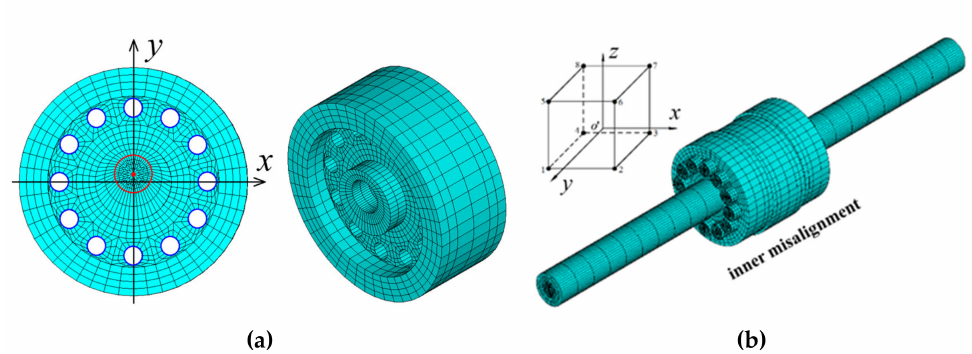
Figure 3. Static model of rod–disk rotor with inner misalignment. ( a ) Model of flawed disk; ( b ) Model of flawed